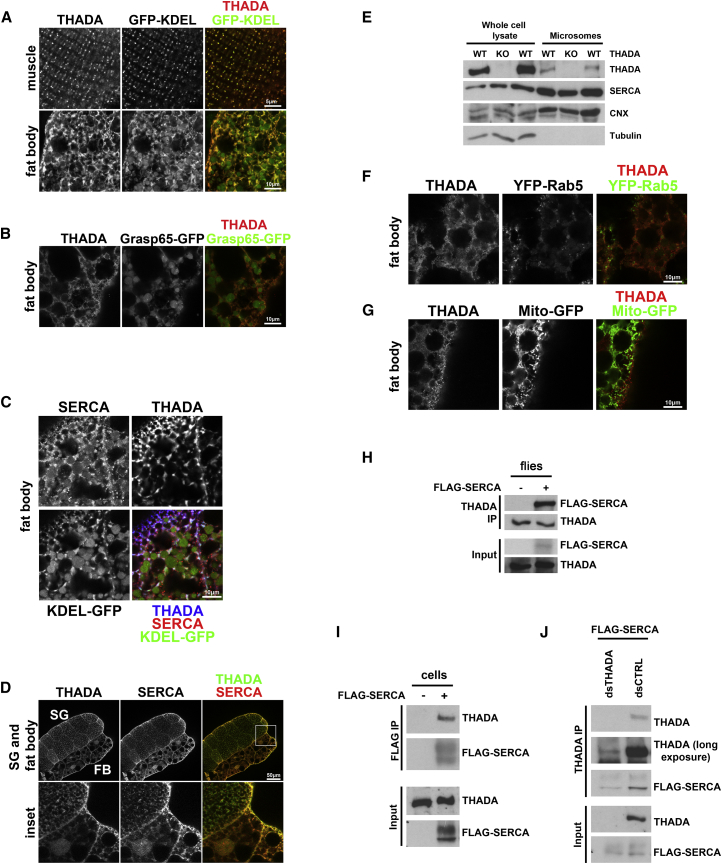
Drosophila THADA Localizes to the ER and Interacts Physically with SERCA(A and B) THADA localizes to the ER and not the Golgi. Larval tissues expressing either GFP-KDEL (A) or the Golgi marker Grasp65-GFP (B) were stained to detect THADA. In muscle GFP-KDEL marks the ER, whereas in fat body GFP-KDEL marks both the ER (stronger reticulate pattern) and the Golgi (weaker round vesicles).(C) GFP-KDEL marks both the ER and the Golgi in fat body. Fat body expressing GFP-KDEL was immunostained to detect endogenous SERCA and THADA. GFP-KDEL marks both the reticulate ER, stained by the ER marker SERCA, and the Golgi which appears as round vesicles. THADA co-localizes with SERCA on the ER.(D) THADA co-localizes with SERCA. Larval salivary gland (SG) and fat body (FB) were stained to detect endogenous THADA and SERCA. Lower panels show a 4× magnification of the indicated region (Pearson's R = 0.74 for entire FB + SG).(E) THADA is present in microsomal preparations, purified by ultracentrifugation of larval lysates. Calnexin (CNX) and tubulin serve as positive and negative controls for ER purification, respectively.(F) THADA does not localize to early endosomes, marked with YFP-Rab5. Fat body from animals expressing YFP-Rab5, immunostaining to detect THADA localization.(G) THADA does not localize to mitochondria, marked with mito-GFP. Fat body from animals expressing mito-GFP, immunostaining to detect THADA localization.(H) FLAG-SERCA interacts with endogenous THADA. Immunoprecipitation of endogenous THADA from lysates of transgenic adult flies expressing FLAG-SERCA.(I) FLAG-SERCA interacts with endogenous THADA in Kc167 cells. FLAG-SERCA immunoprecipitates from transfected Kc167 cells were immunoblotted with indicated antibodies.(J) Endogenous THADA co-immunoprecipitates FLAG-SERCA from Kc167 lysates. Lysates from THADA knockdown cells serve as a negative control.See also Figure S4.